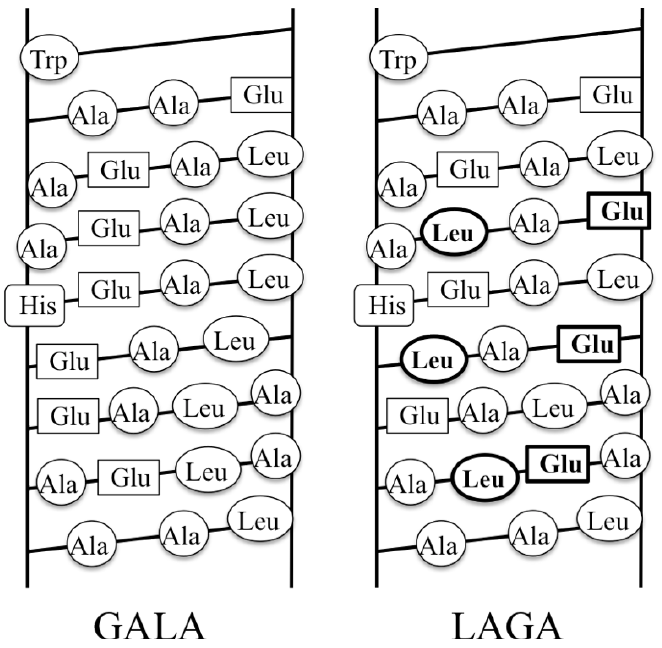
Figure 6. Helical grid representation of the GALA and LAGA peptides designed by Szoka’s group. Difference between these two peptides is the aligning of the glutamic acid and leucines. They are on the different faces of the helix making GALA amphipathic (adapted from Parente et al .